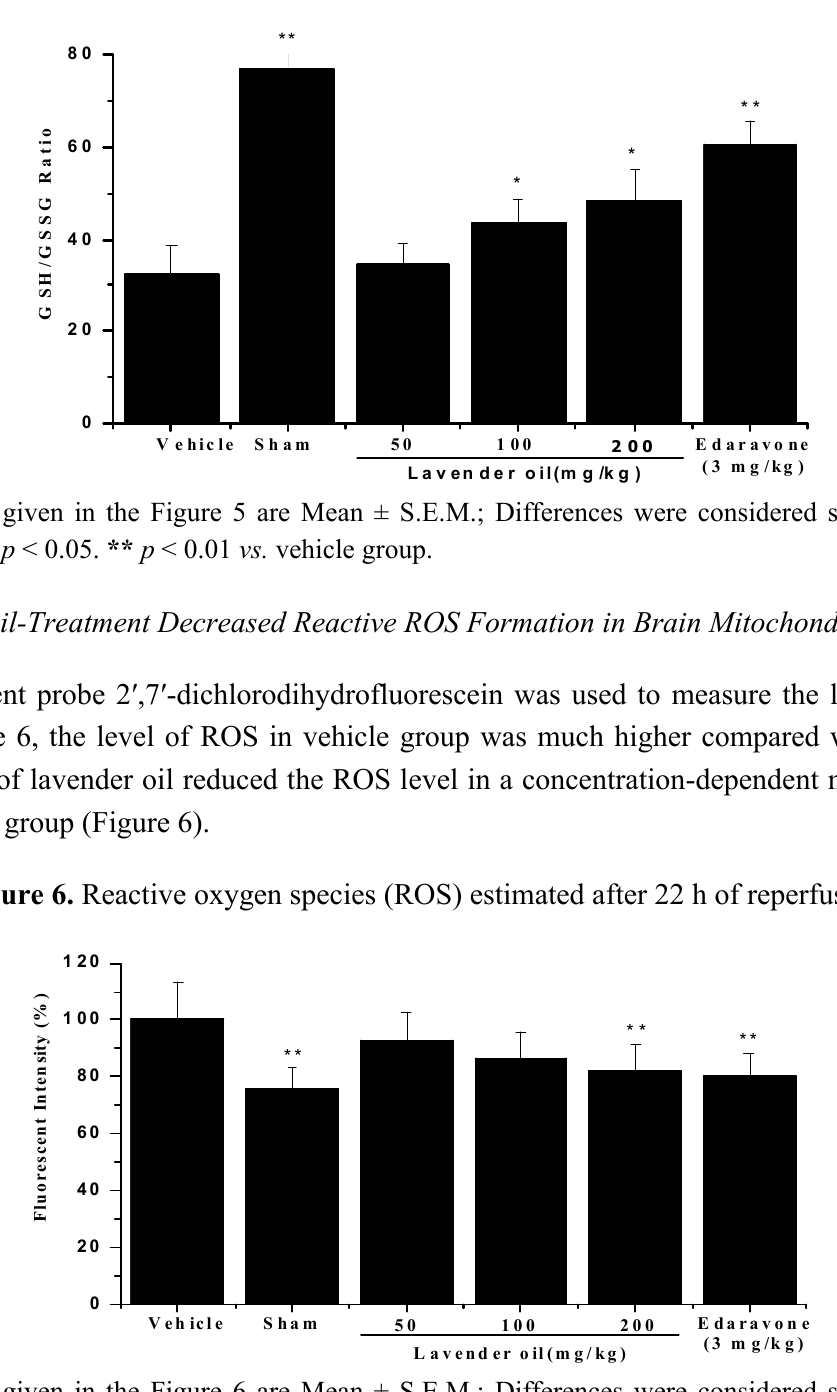
Figure 5. GSH/GSSG ratio measured after 22 h of reperfusion.